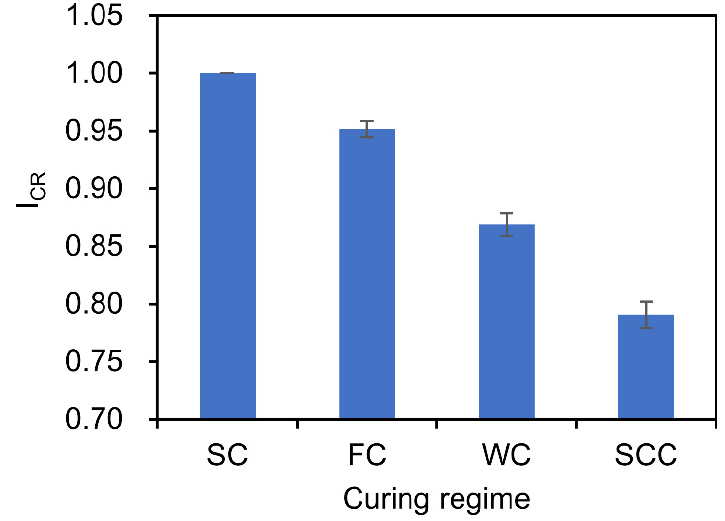
Figure 7. Effect of the curing regime on DRC.